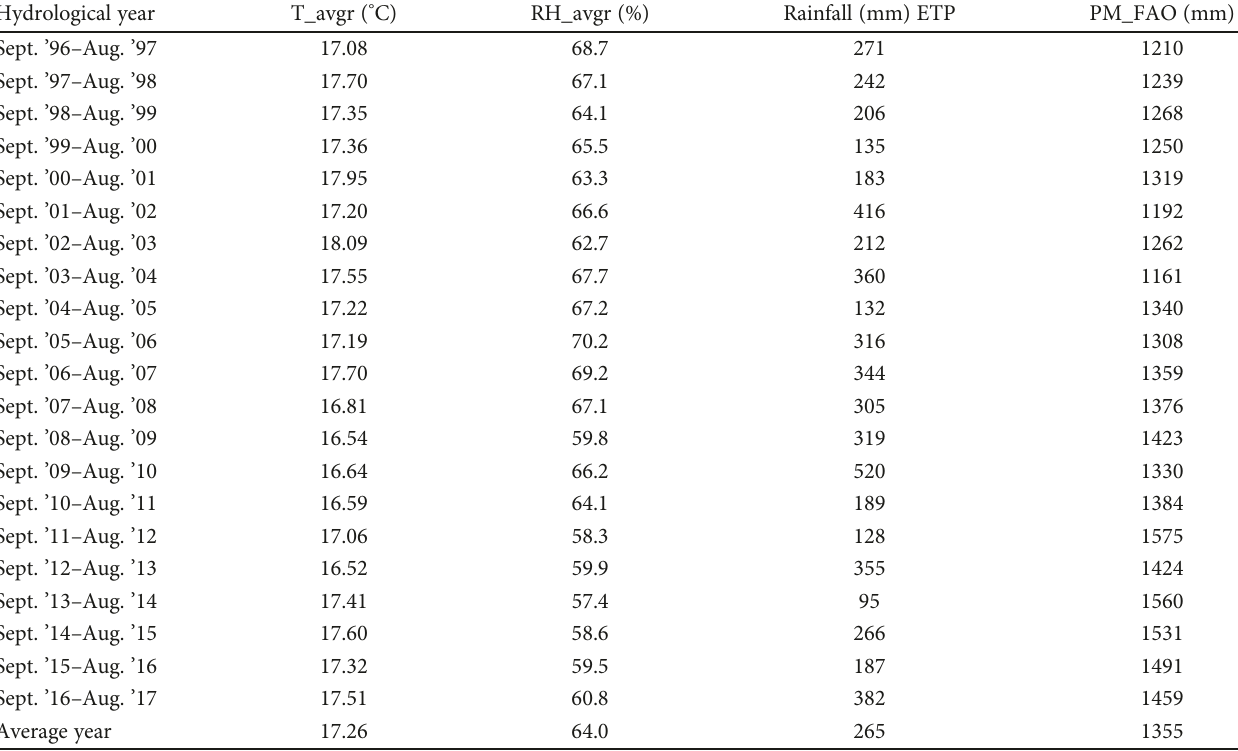
Table 1: Climate conditions in the study are during the last two decades, including the annual-average values of main climatic parameters: air temperature, relative humidity, rainfall, and evapotranspiration according to the Penman-Monteith FAO parameterization scheme [25]. Hydrological